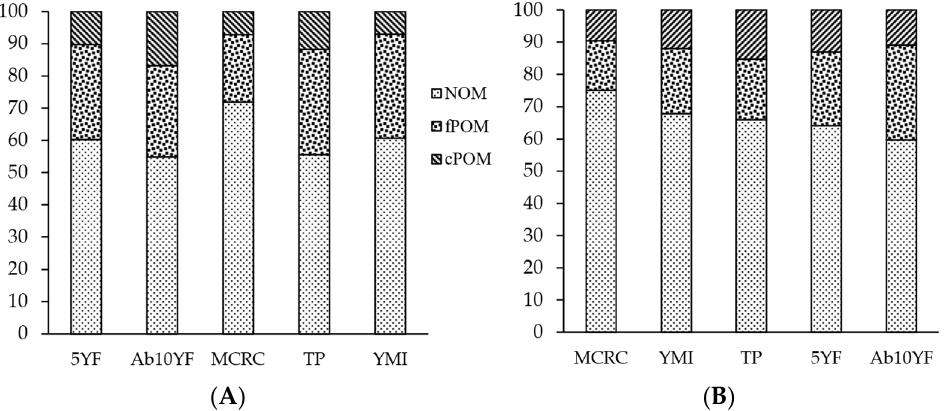
Figure 3. Carbon enrichment factor EF of the organic matter fractions ( A ) 0–10 cm layer, ( B ) 10–20 cm layer. MCRC: maize–cotton relay cropping; 5YF: 5-year fallow; Ab10YF: above 10-year fallow; YMI: yam–maize intercropping system; TP: teak